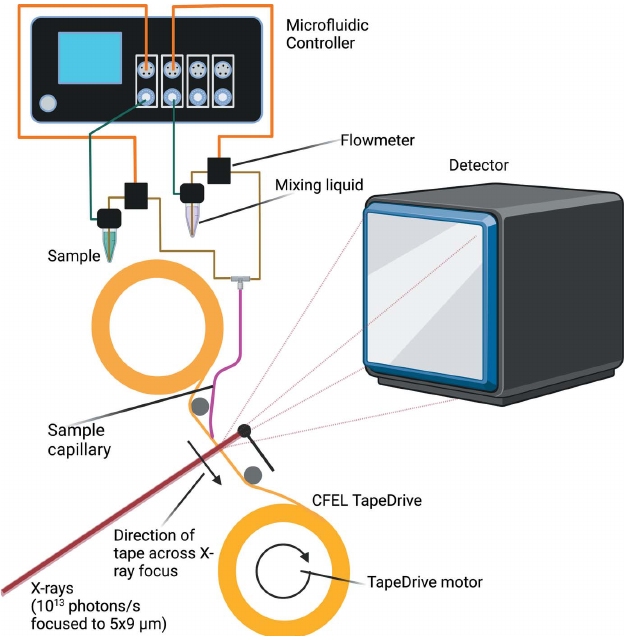
Figure 1 Schematic of the TapeDrive setup as used in this study. The sample capillary can be used with and without mixing, the installation remains the same. In this study we did not use the mix-and-diffuse method. The microfluidic controller is connected to the approximately 6 bar pressur- ized air available at PETRA III. The microfluidic controller and TapeDrive are controlled through a notebook that can be operated remotely from the hutch. TapeDrive is mounted on the motors that otherwise move the